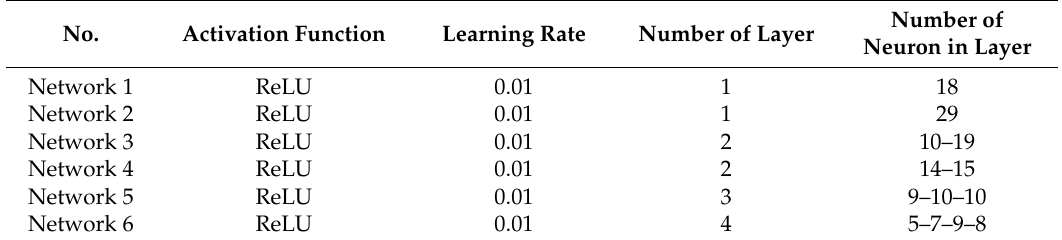
Table 6. Running conditions for the ANN